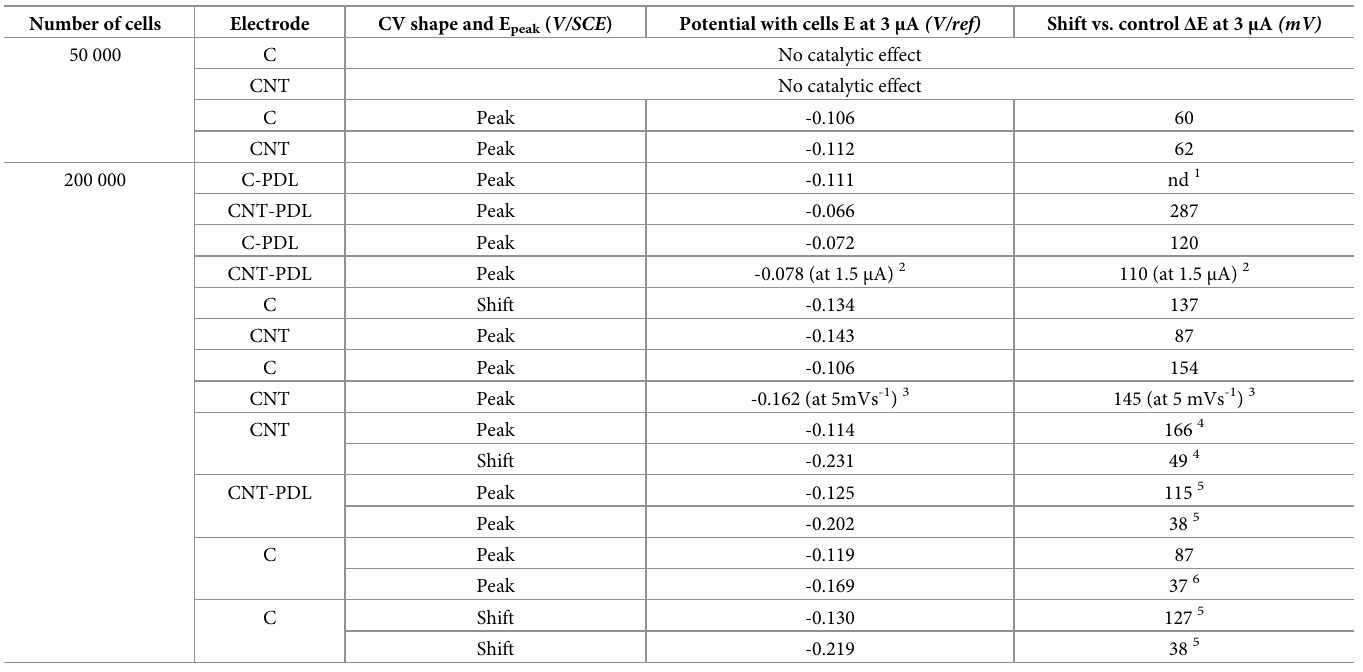
Table 2. Analysis of the reactors incubated for 4 hours with MRC5